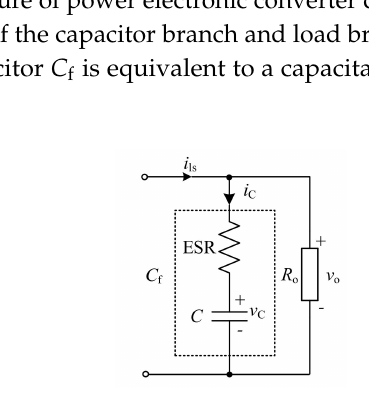
Figure 3. Output structure of power electronic